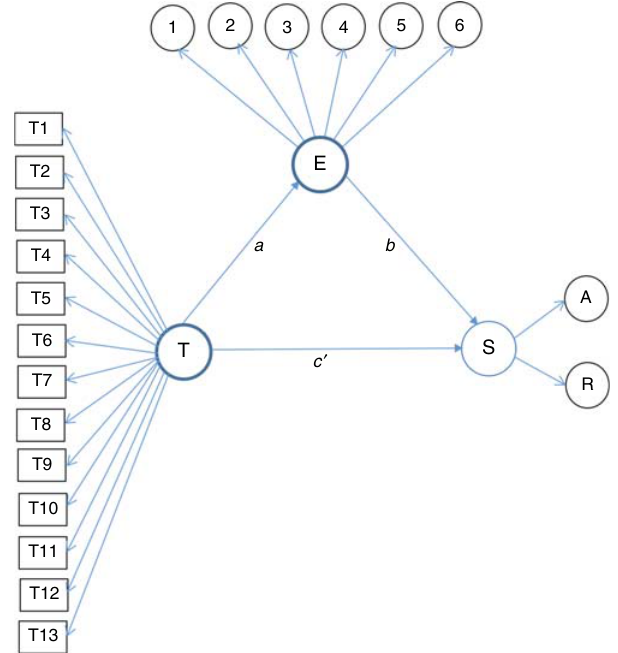
Figure 1. Teachers ’